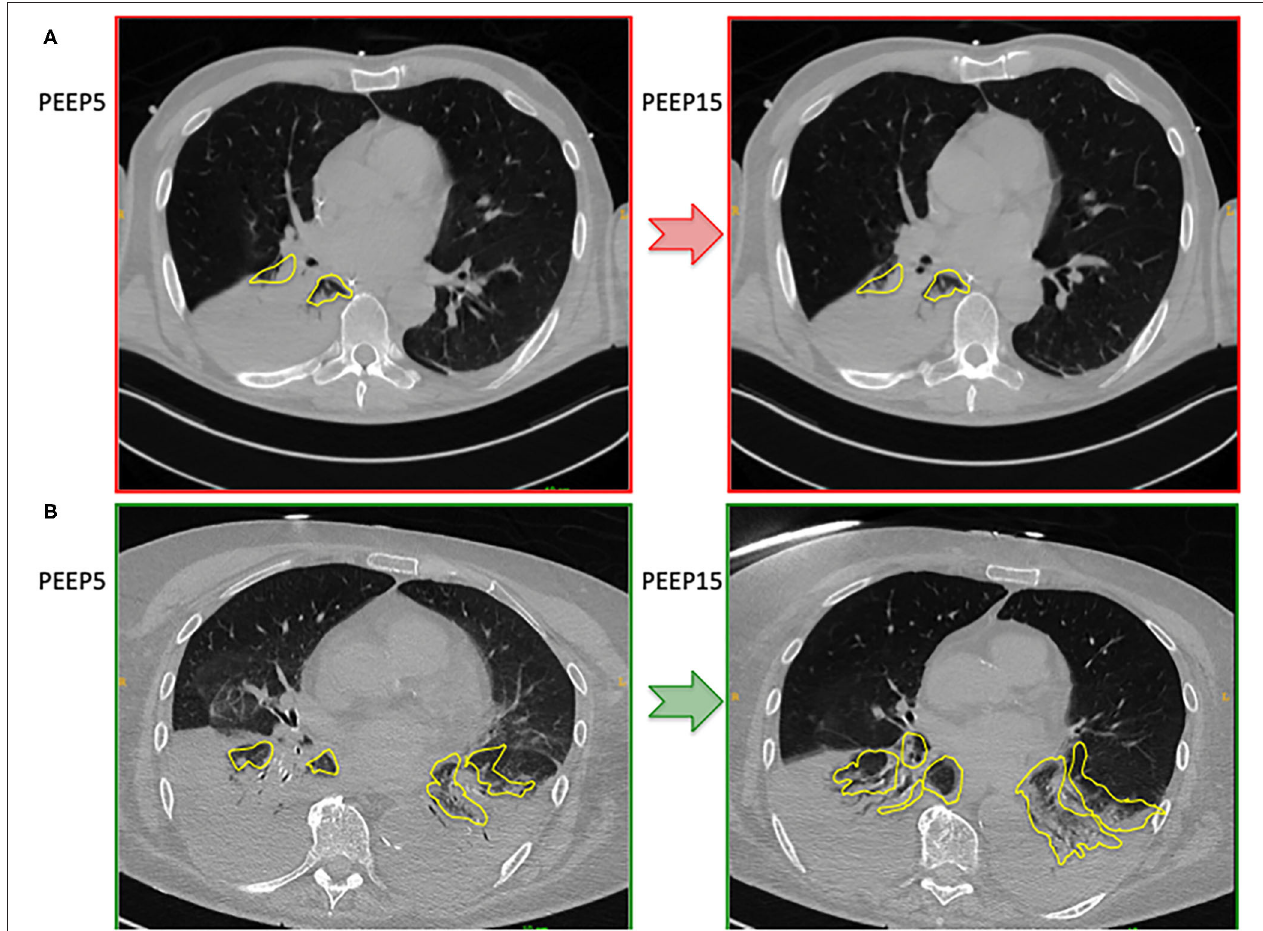
FIGURE 1 | Representative cases representing CT images at 5 and 15 cmH 2 O of PEEP in a patient with poor alveolar recruitment (A) and good alveolar recruitment (B)